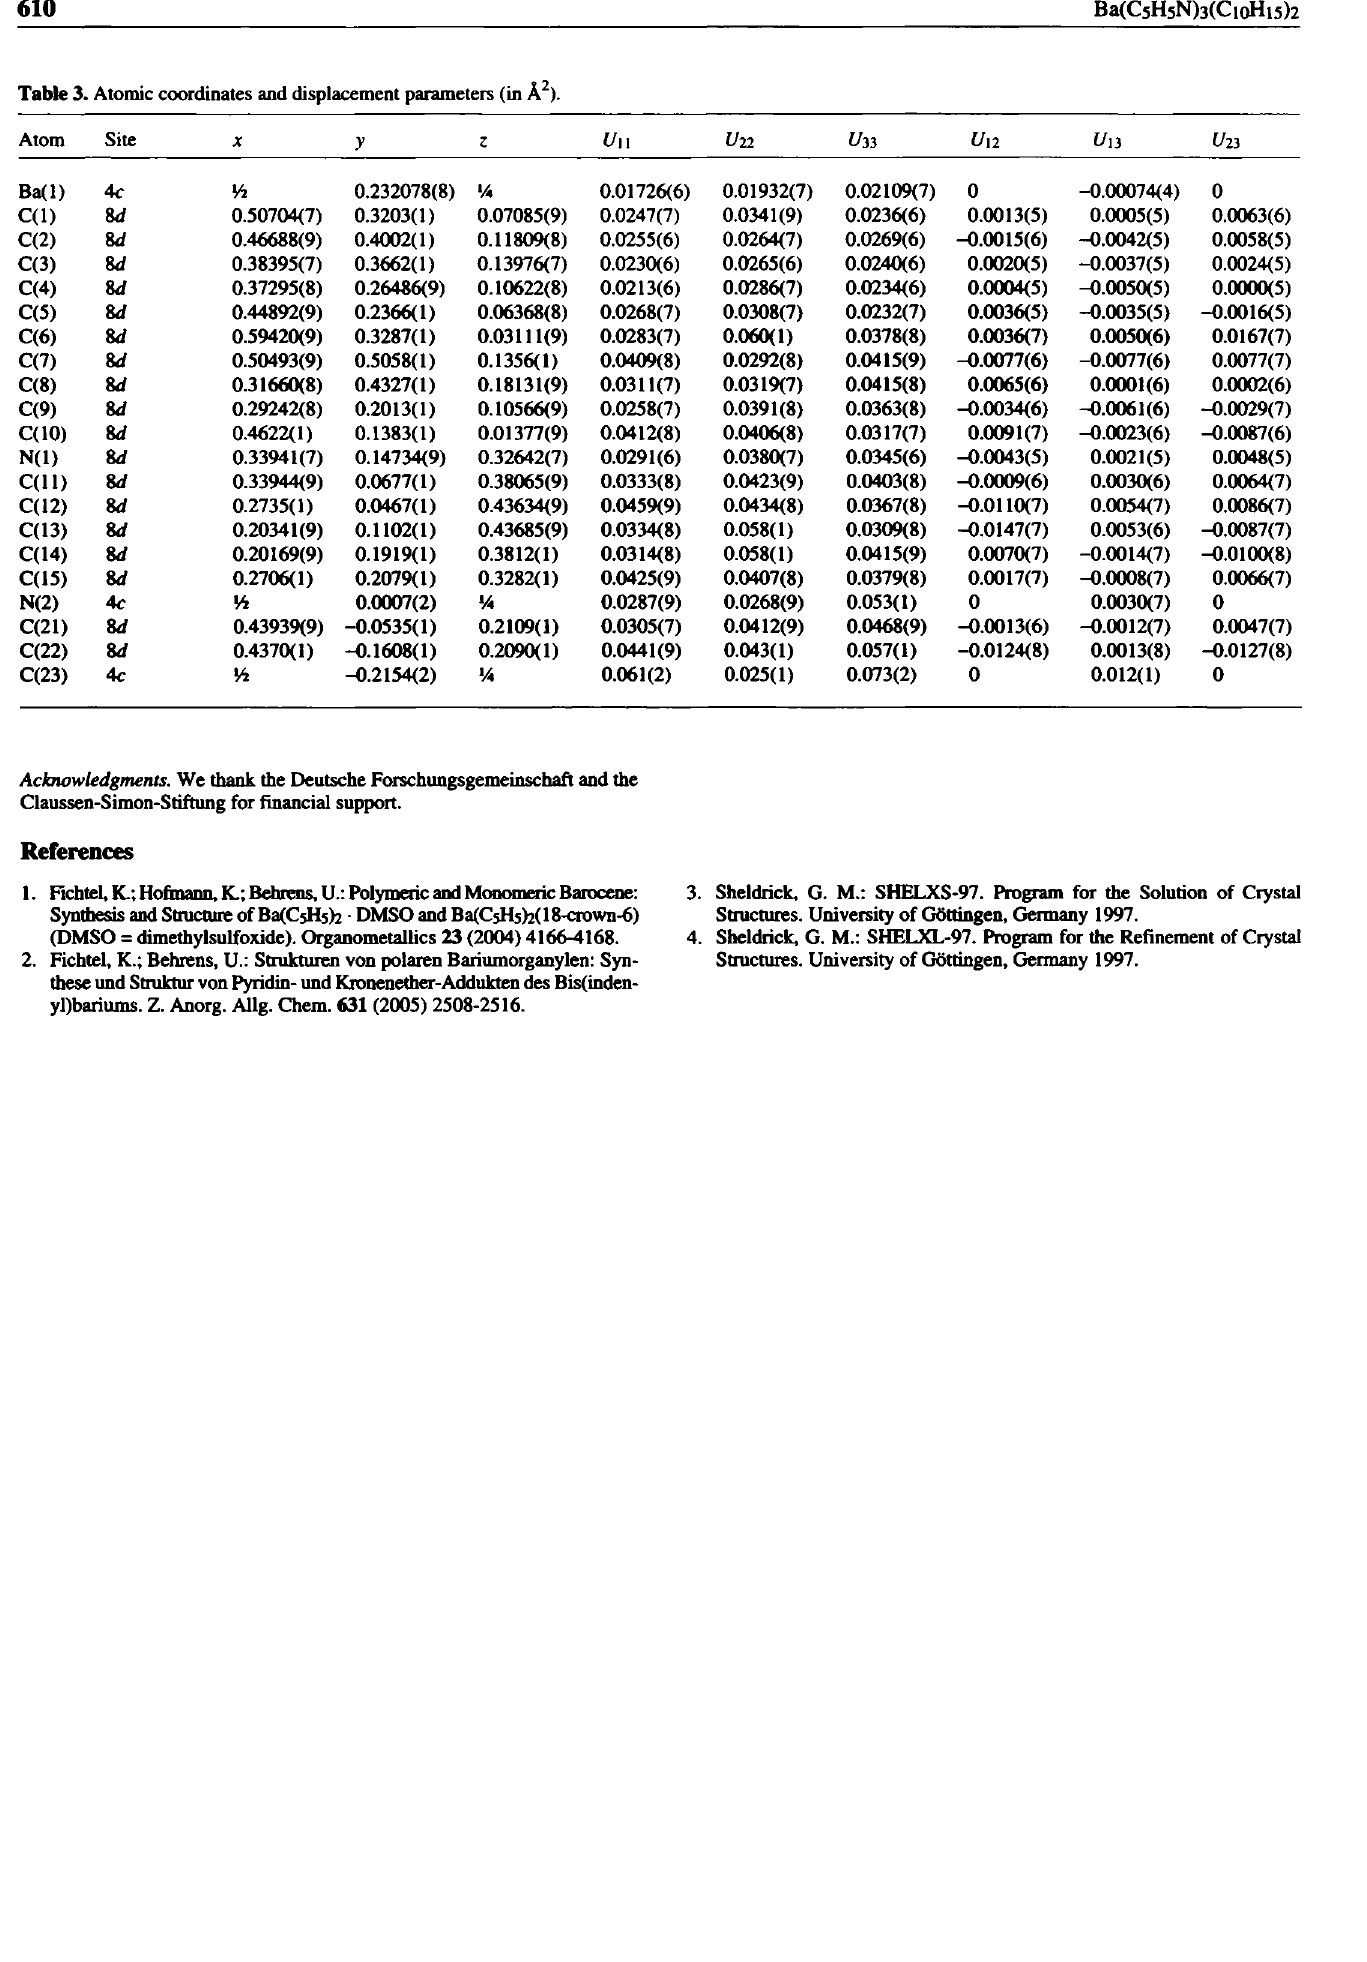
Table 3. Atomic coordinates and displacement parameters (in Ä 2